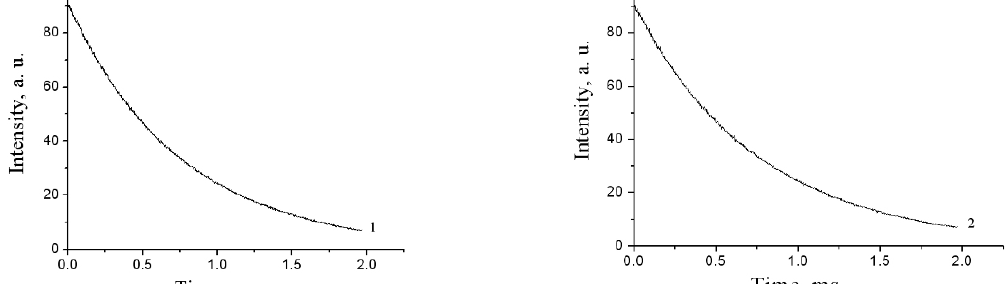
•phen in solid state. 3